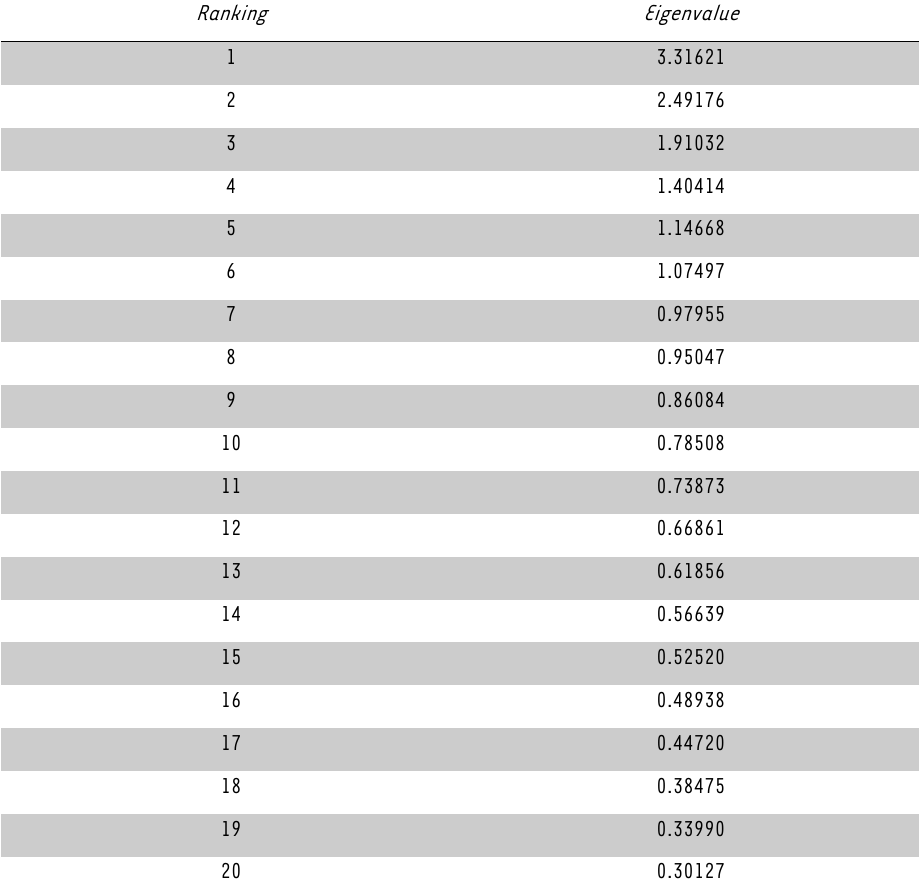
Histogram of eigenvalues of unaltered correlation matrix Ranking Eigenvalue 1